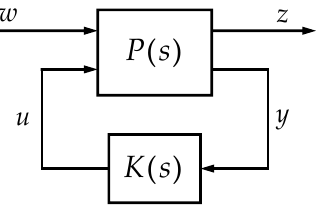
H configuration. Figure 3. A schematic drawing of a standard H ∞ 